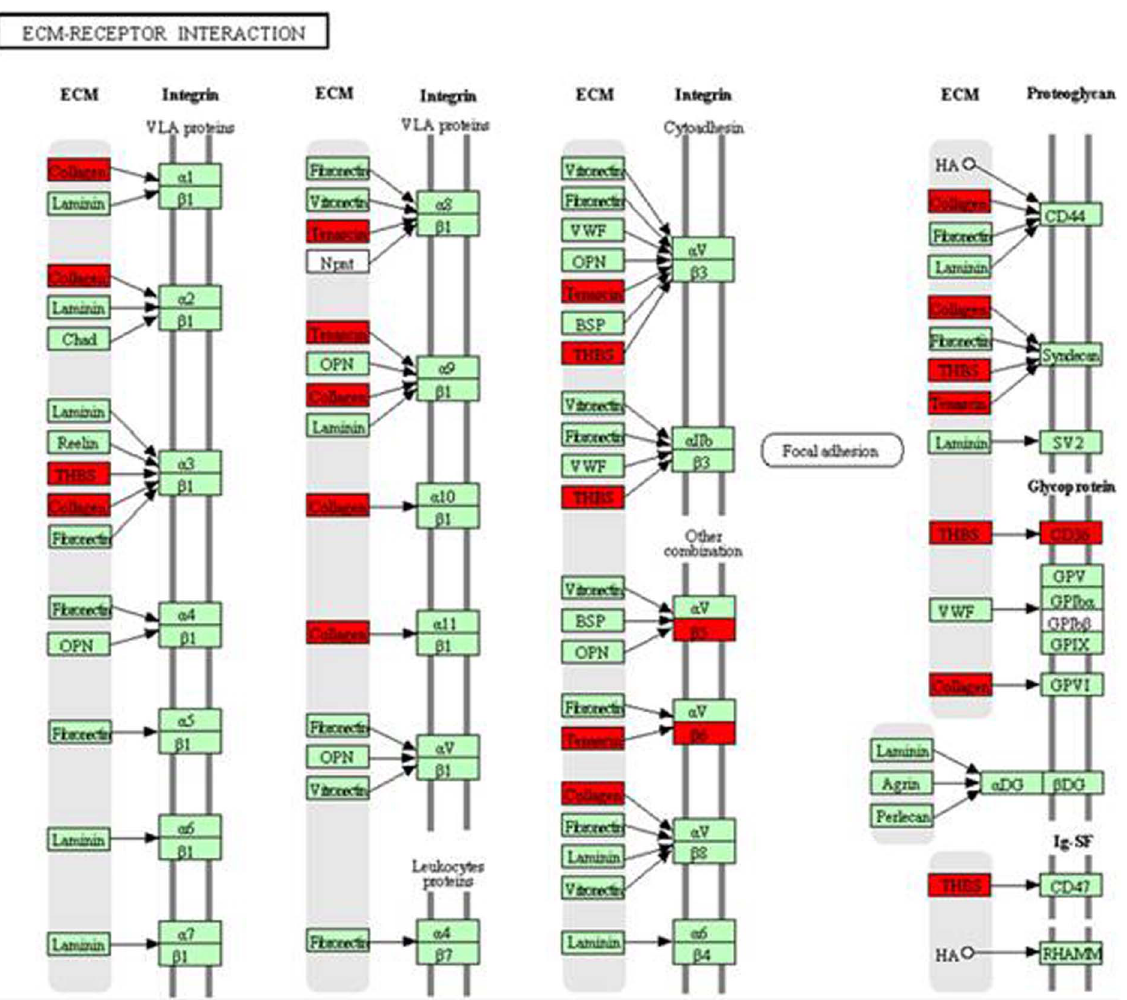
Figure 5. The ECM-Receptor interaction pathway is transcriptionally regulated throughout the onset of lactation. Red nodes represent genes downregulated during stage I of lactogenesis and then upregulated during stage II of lactogenesis.